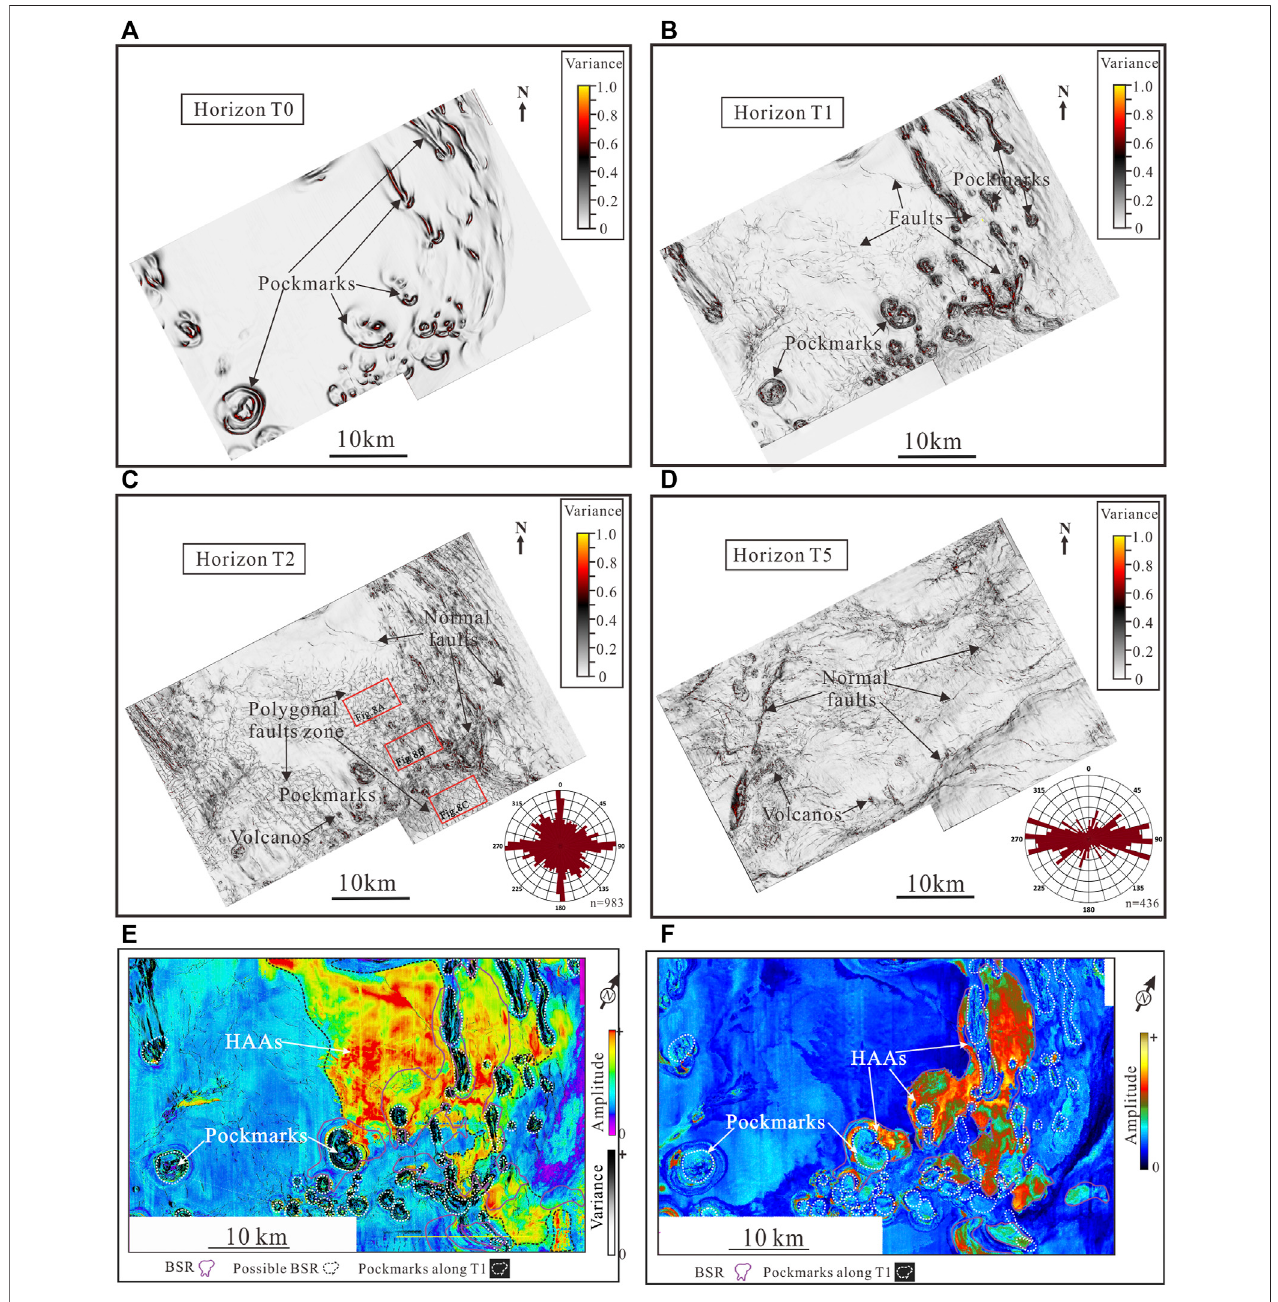
FIGURE5|(A) – (D) ThetimeslicesofthecoherenceattributealonghorizonsT0,T1,T2,andT5,respectively.Themapsshowthevariationsofpolygonalfaultsand faultsystemsinthestudyarea.TheinsetrosediagramsofhorizonsT2andT5showingthestrikesoffaults,respectively. (E) Maximumamplitudeattributemapextracted along T1 with a time window 60 ms above this layer, which overlays on the fault probability volume obtained from variance slice along horizon T1, showing the relationship between HAAs, faults, and pockmarks. (F) Maximum amplitude attribute map extracted along BGHSZ with a time window of 60 ms above and the pockmarks found in the horizon T1 showing the relationship between the distribution of the HAAs and the pockmarks.